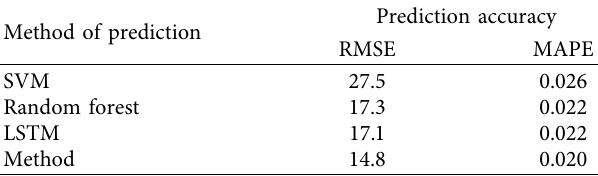
Table 3: Weekend power load forecast results.